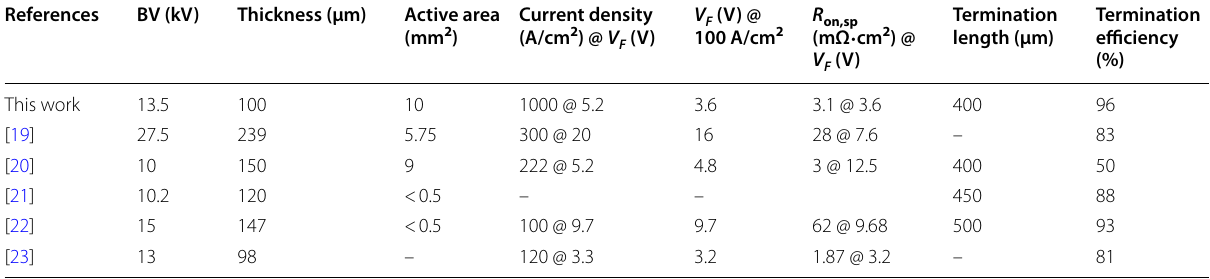
Table 2 Summary and comparison of characteristics of the recently reported 4H-SiC PiN rectifiers and this